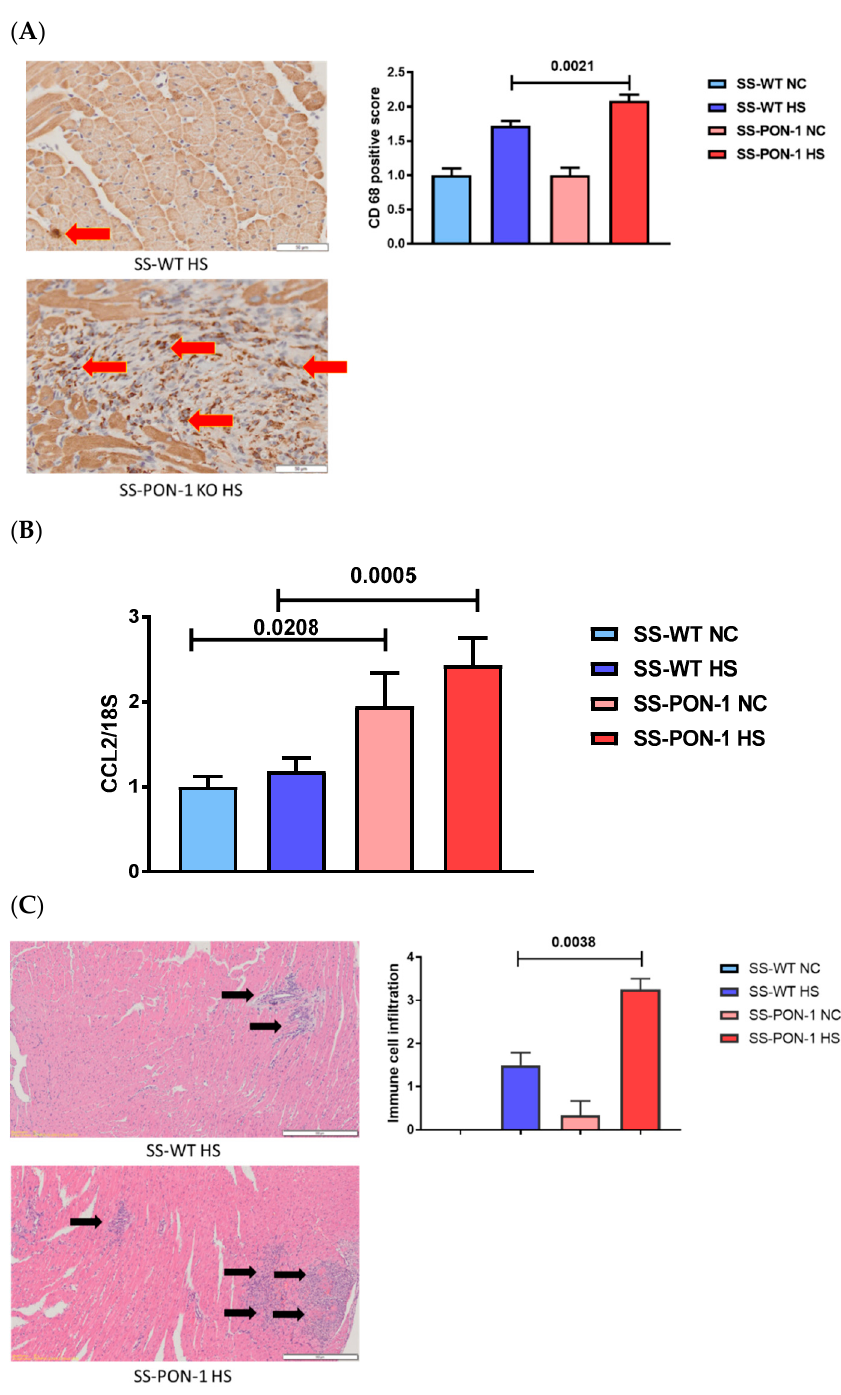
Figure 5. Targeted mutation of paraoxonase-1 leads to a significant increase in cardiac inflammation in a hypertensive renal disease model. ( A ) SS-PON-1 KO HS rats demonstrate significant increase in CD68-positive immune cells compared to SS-WT HS rats. ( B ) SS-PON-1 KO HS rats demonstrate significant elevation in inflammatory gene CCL2 expression as compared to SS-WT HS rats. ( C ) SS- PON-1 KO HS rats demonstrate significant increase in interstitial immune cell infiltration compared to SS-WT HS rats. Representative H&E histology (left) and quantification (right) ( N = 8). Data are presented as the mean ± standard error of the mean. One-way ANOVA and post hoc multiple comparison tests were used to assess statistically significant differences between the